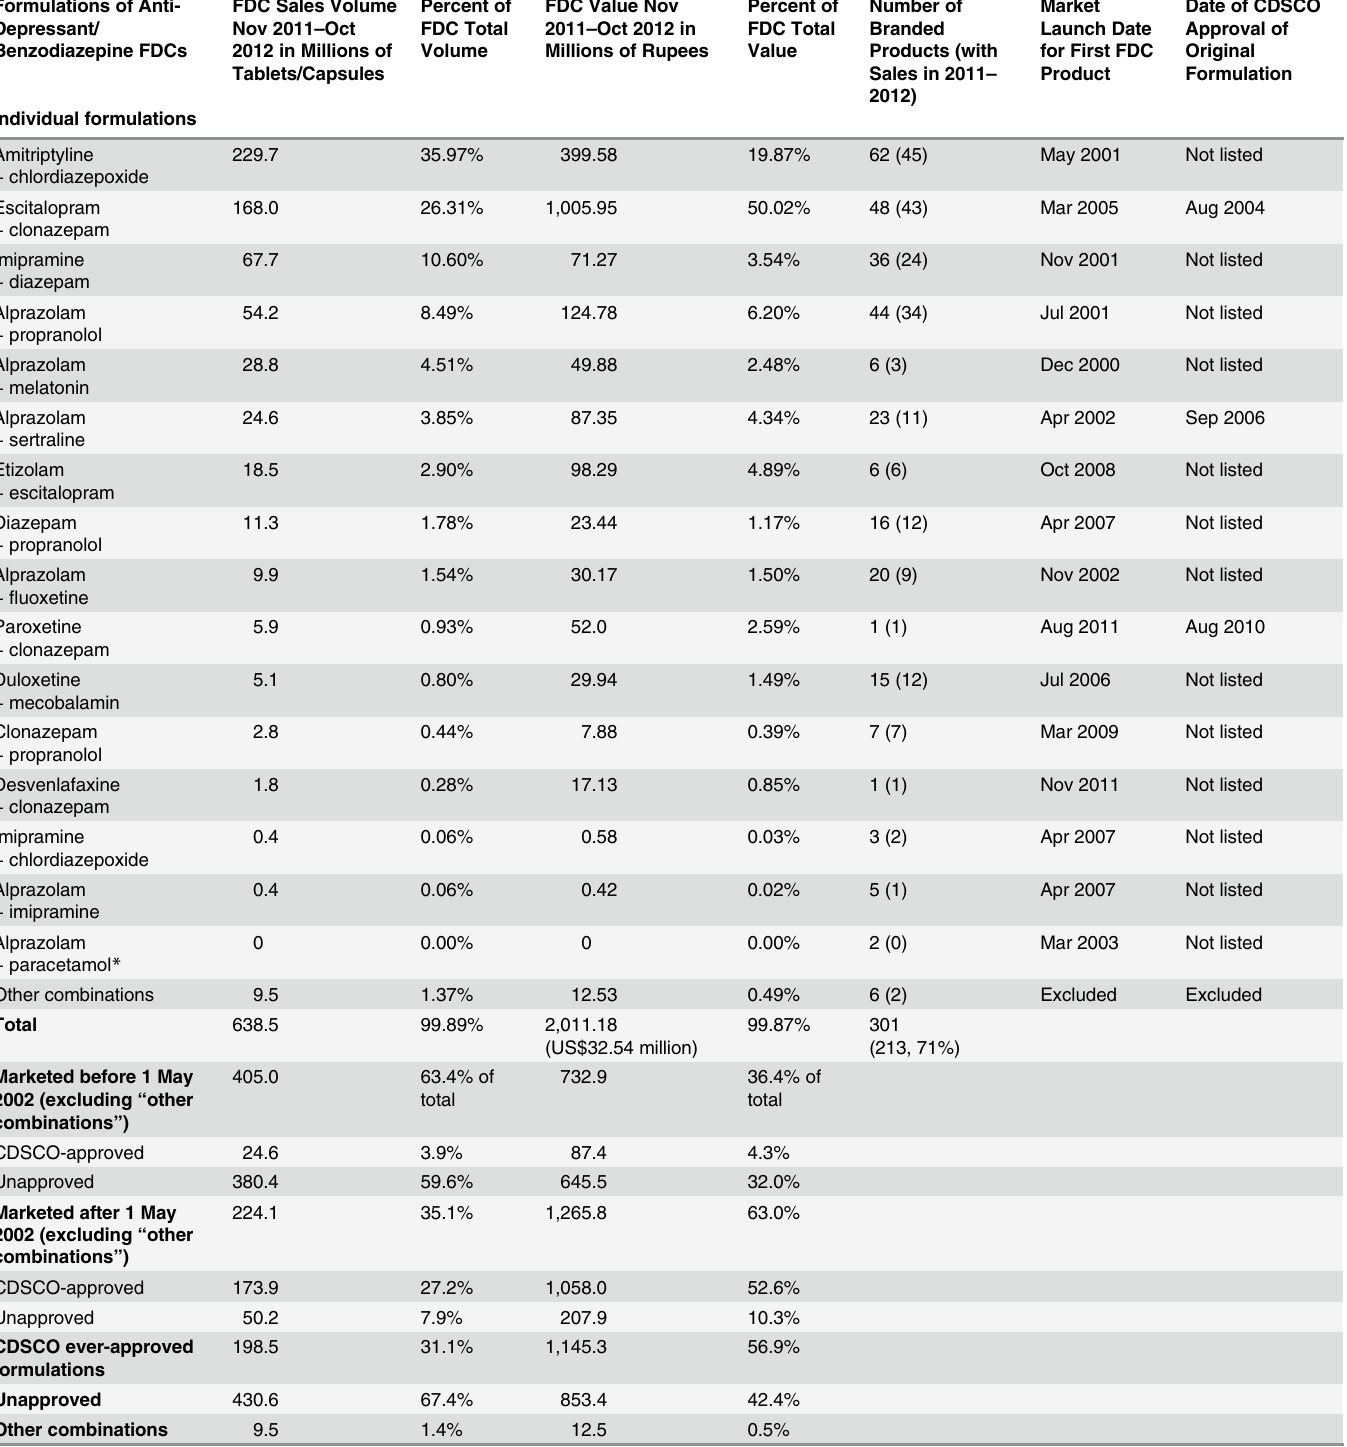
Table 3. Anti-depressant/benzodiazepine FDC formulations marketed in India. Formulations of Anti-